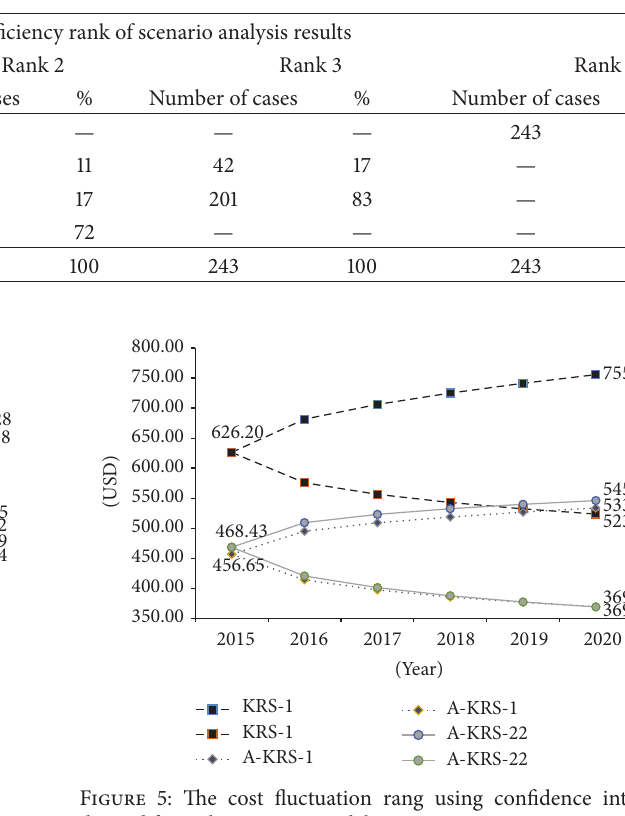
Figure 4: Cost estimation results of disposal alternatives using the ARIMA model and inflation rates.